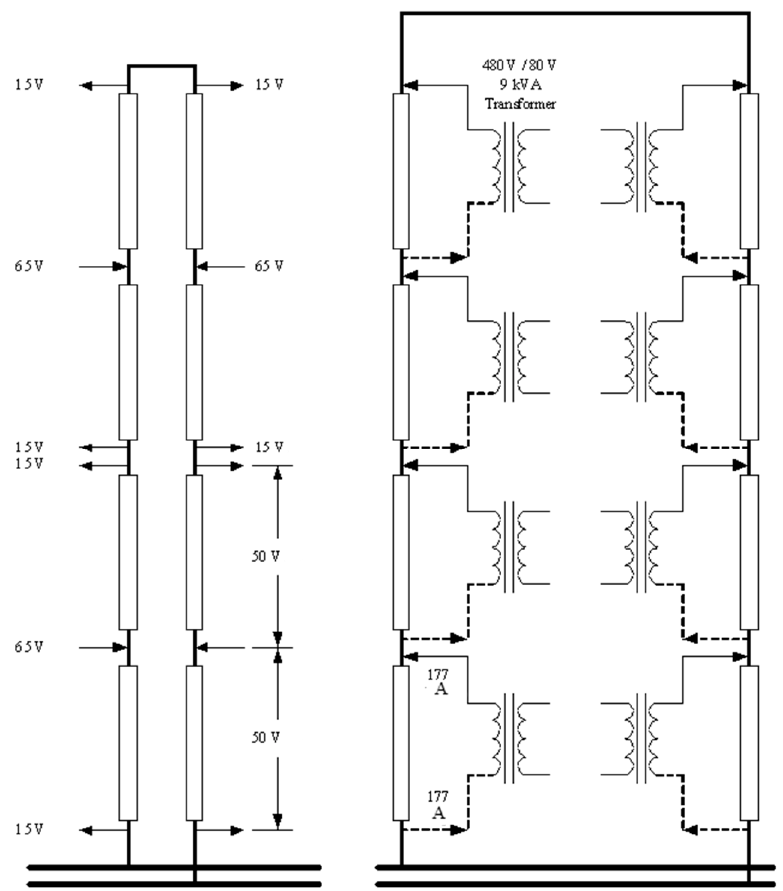
Figure 15. A design schematic for a system with one transformer per solar collector assembly (SCA), given with one possible voltage and amperage. Table 7. Necessary electrical system characteristics to meet the target condition of a one-day melting time for a tube with a compromised vacuum. NA represents that no American wire gauge (AWG) rating is sufficient.